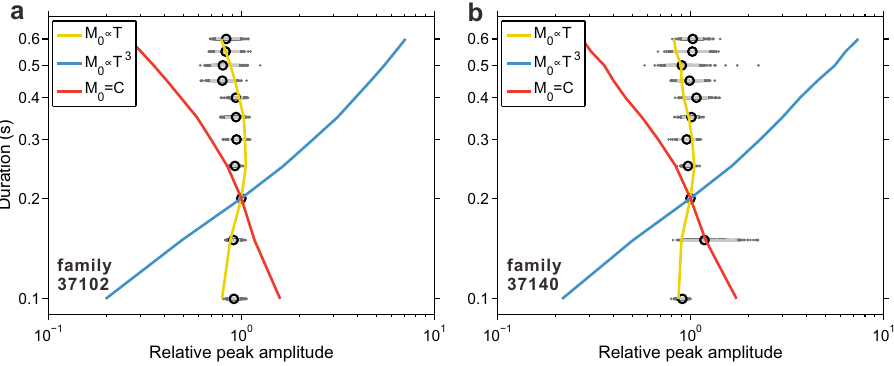
Fig. 6 | Evidence for linear moment-duration scaling from amplitude obser- vationsoflow-frequencyearthquakes.a , b Blackcirclesdenotetheobservations: duration vs amplitude forstacks ofLFEs infamily37102and 37140 (component E), respectively. The amplitudes are normalized by the amplitudeof the 0.2-secstack. The gray dots denote the measurements from bootstrapping the traces 500 times